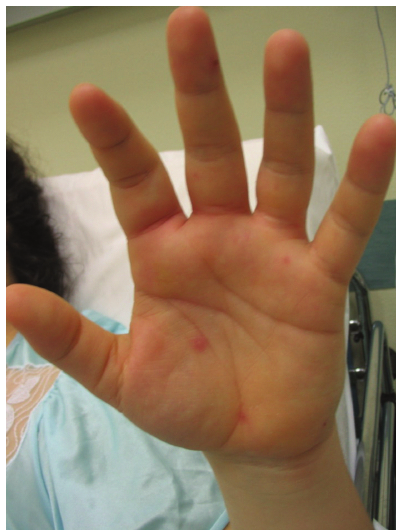
Figure 2: Skin lesions on left palm and on third finger.